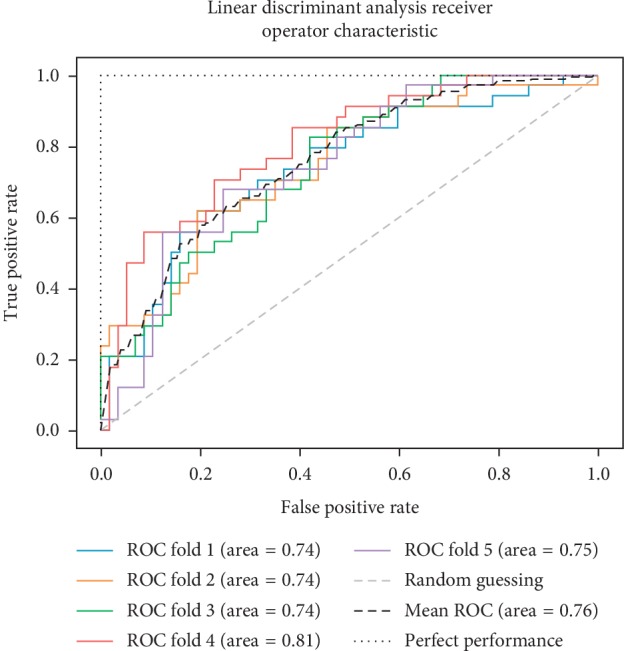
ROC curve for LDA.